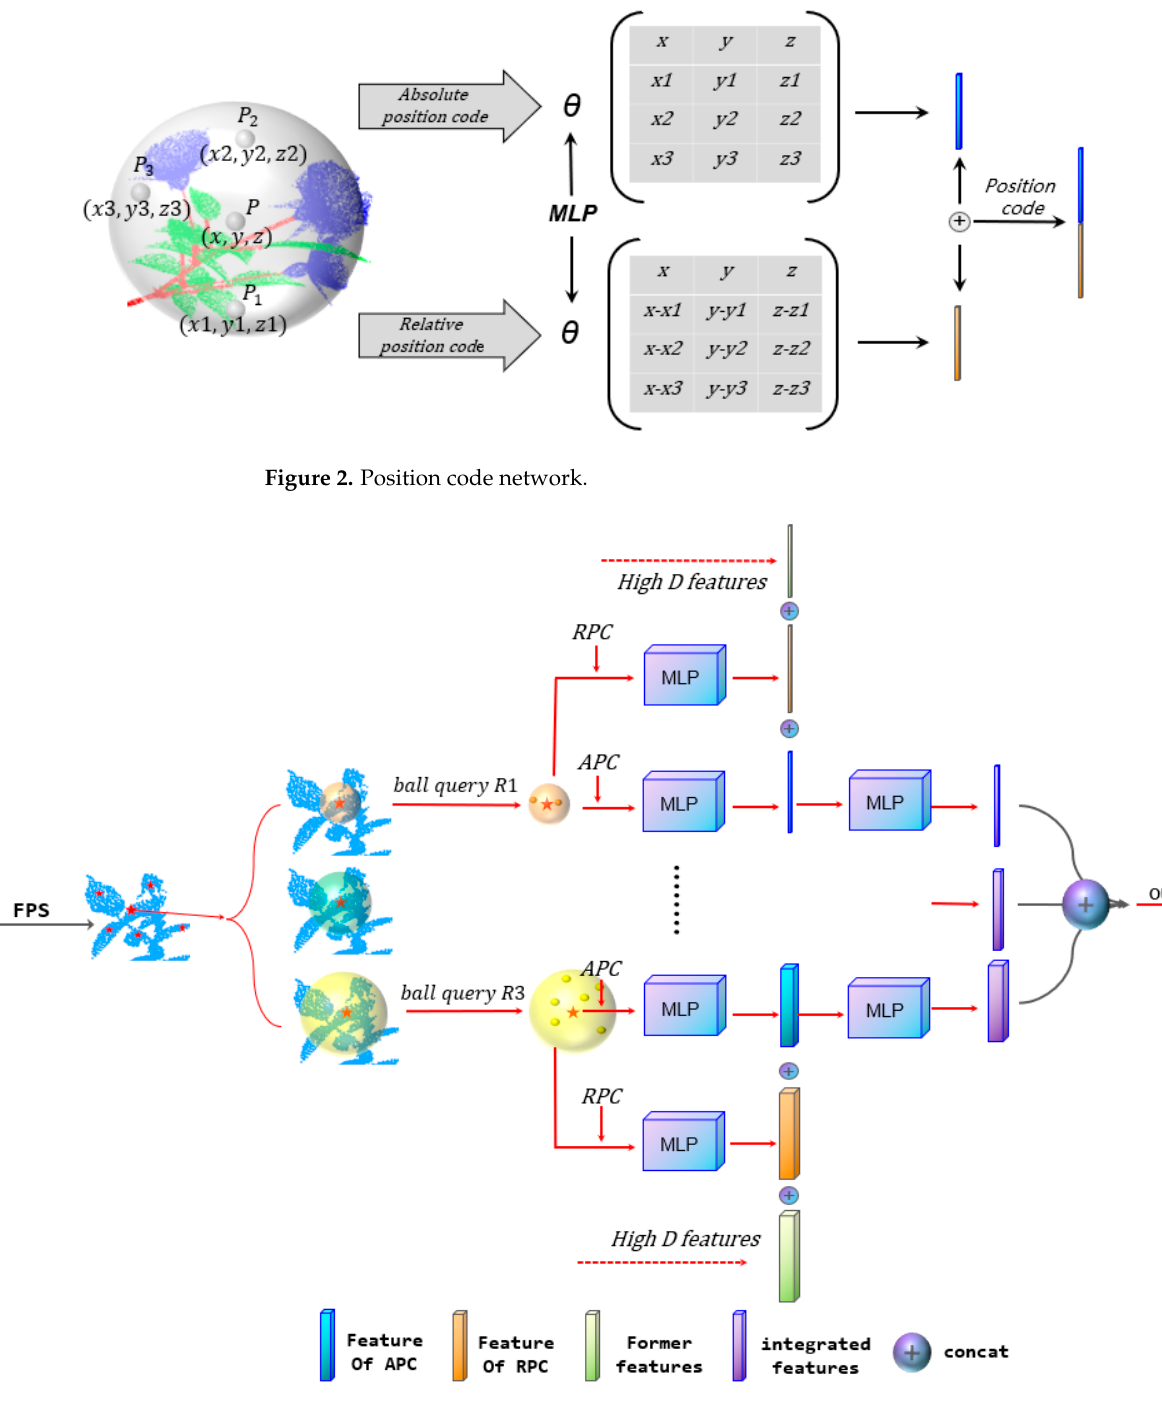
Figure 3. Position code in MSG.